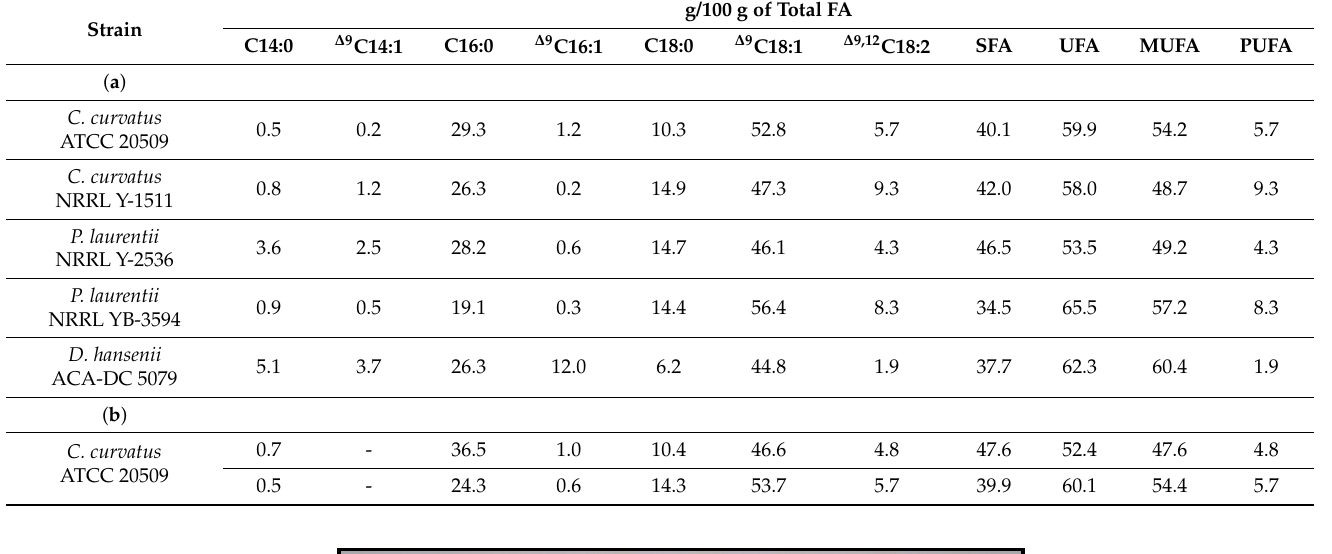
Table 5. (a) Fatty acid composition of the cellular lipids produced by yeast strains cultivated on second CW in shake-flask experiments at the stationary phase of microbial growth. (b) Fatty acid composition of the cellular lipids produced by C. curvatus ATCC 20509 at two different time-points, during fed-batch cultivation on second CW. The individual FA content was expressed as weight percentage (g/100 g of total FA).